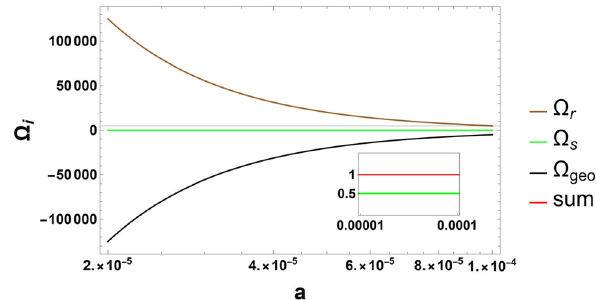
Fig. 2 Behaviour of the density parameters as a function of the scale factor with logarithmic scale in a . The values of the density parameters todaywerechosentobe (cid:18) r , 0 = 5 × 10 − 5 and (cid:18) s , 0 = 0 . 5.Furthermore, g 3 = 0 . 34 M 2 p was taken, meaning g 1 = 2 . 3 × 10 115 via